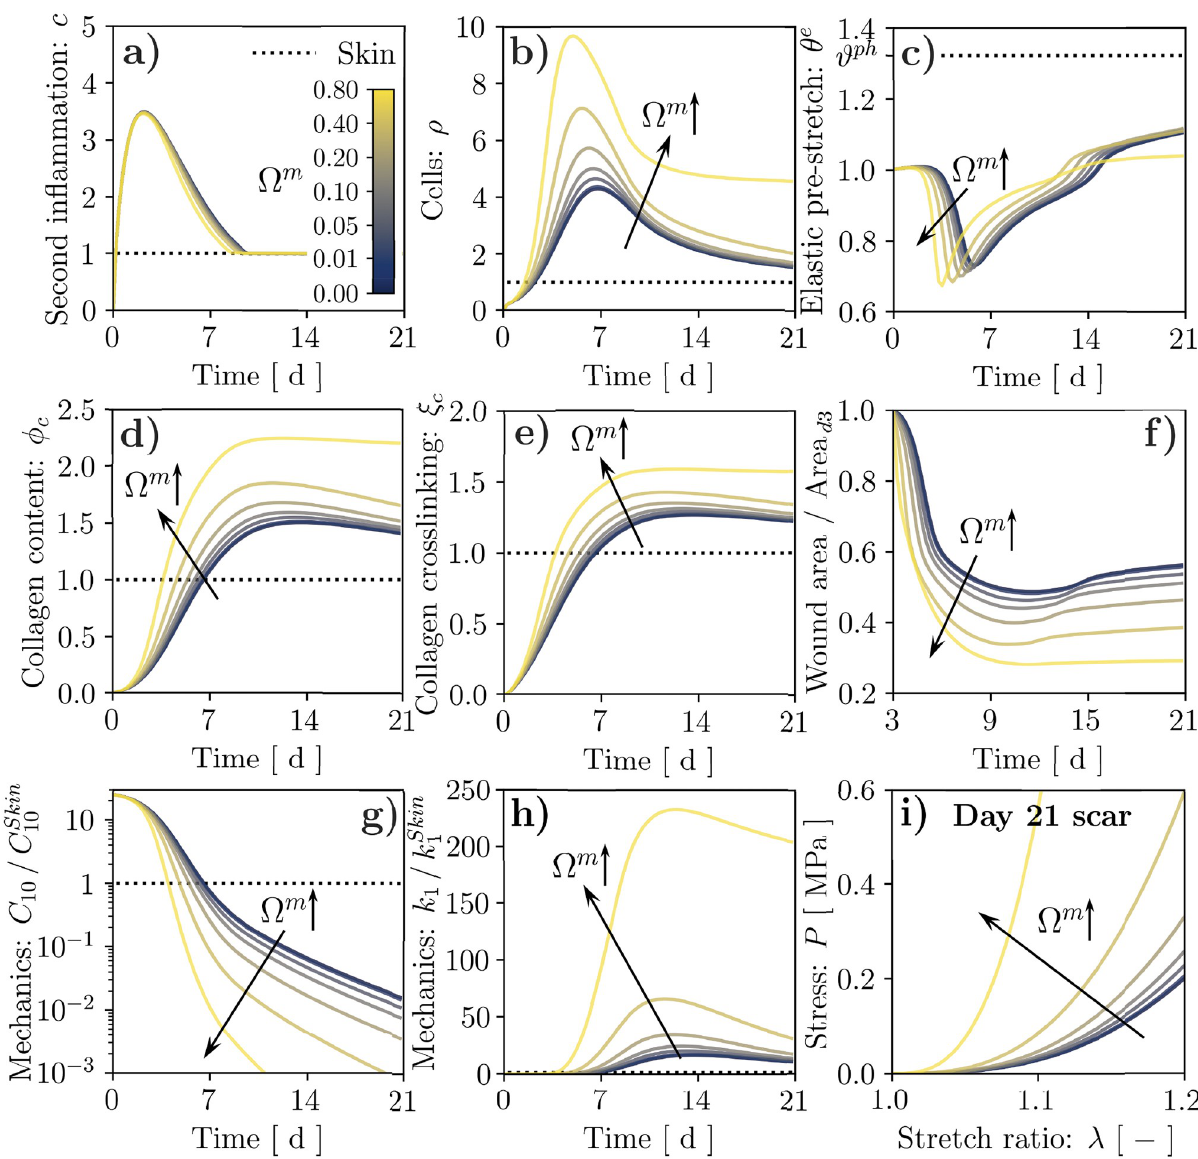
Fig 8. Results of wound healing simulation over a 21-day period for stiffness-mediated mechanosensitivity and alternative values of the coupling strength, as controlled by the parameter O m . Temporal evolution of: second inflammatory signal, c , ( a ); cell population, ρ , ( b ); tissue elastic stretch, θ e ( c ); tissue collagen content, ϕ , ( d ); collagen crosslinking, ξ , ( e ); wound area change ( f ); mechanical parameters C c c wound healing outcome in terms of tissue mechanical behavior is visualized by evaluating its tensile response at day 21 post-wounding ( i